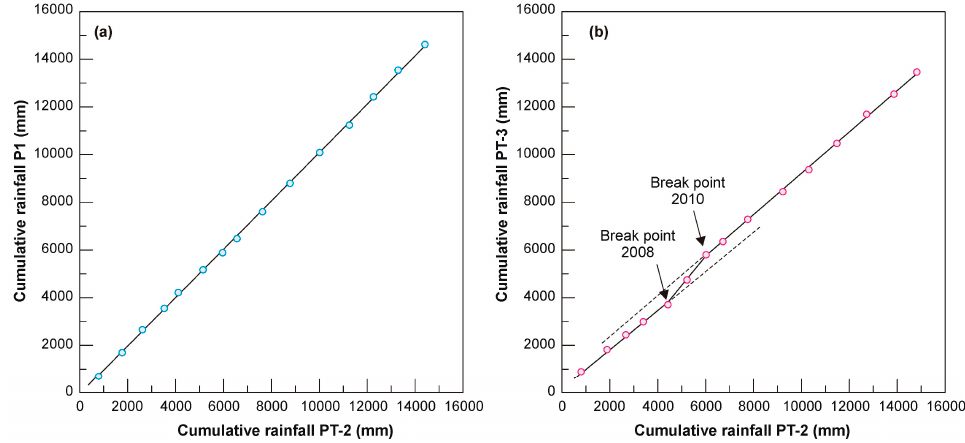
Figure 3. Double-mass curves for detecting the consistency of rainfall data. ( a ) Comparison be- tween PT-2 and P1. ( b ) Comparison between PT-2 and PT-3. The location of rainfall stations is in Figure